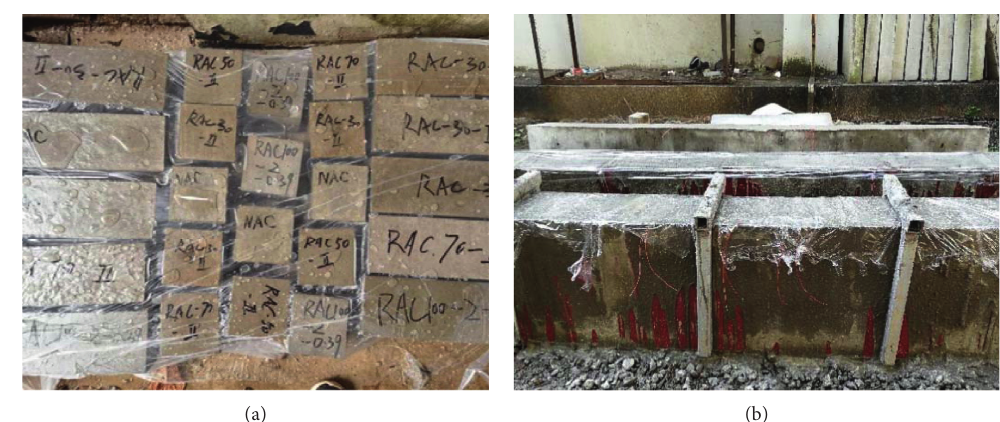
Figure 2: Experimental specimens. (a) Curing test block under the same condition. (b) Casting and forming.